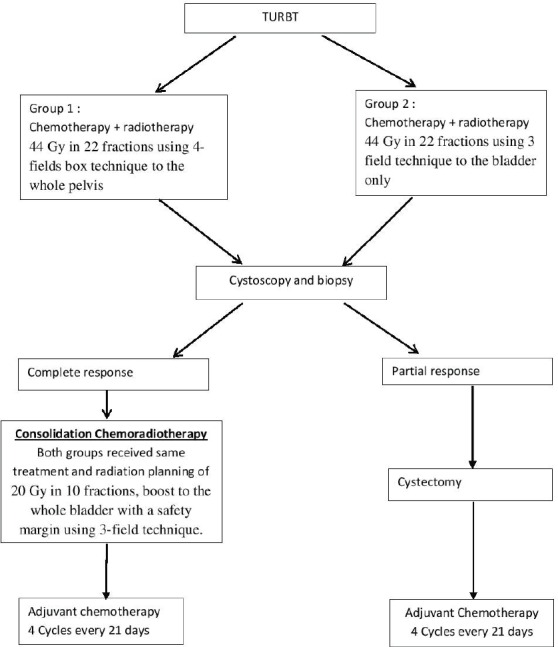
General study design.